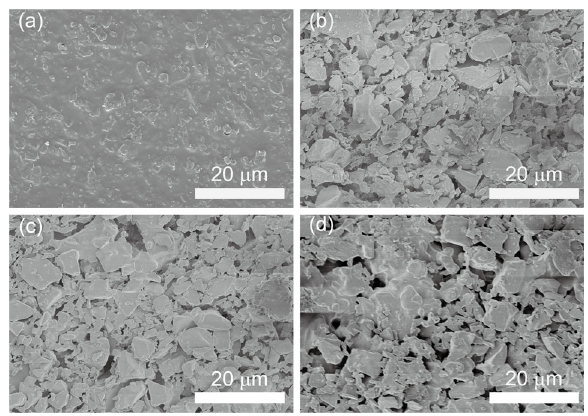
Fig. 1 SEM images of (a) green mullite hollow fiber membrane, and its sintered products obtained under different temperature: (b) 1520 ℃ , (c) 1570 ℃ , and (d) 1630 ℃ .